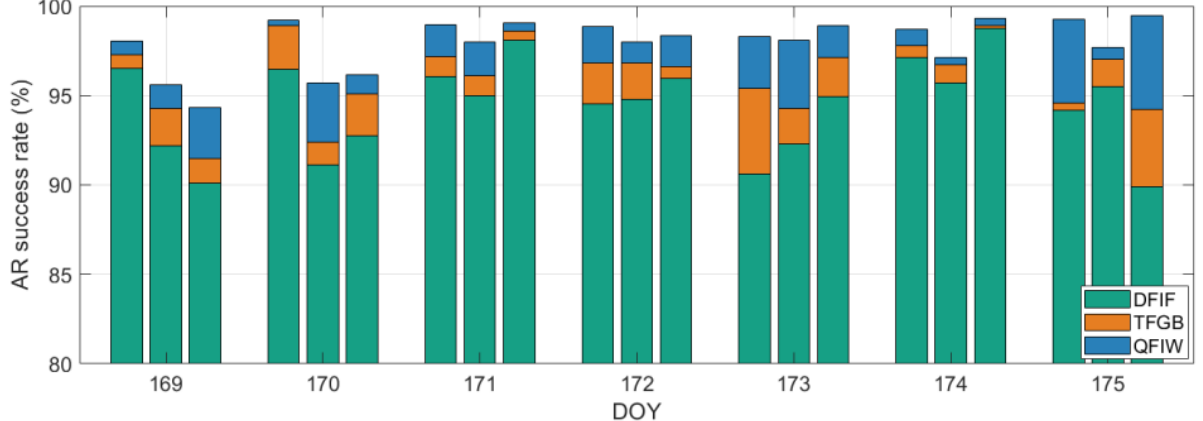
Figure 12. AR success rate of seven days under three models.